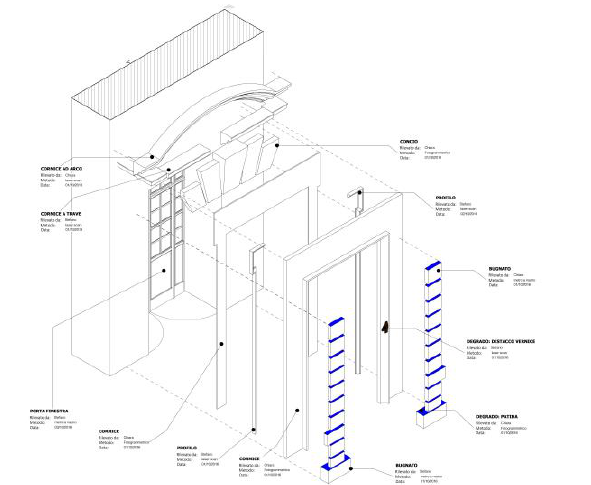
Figure 12. Exploded axonometry that shows the complex semantic decomposition of each single architectural subcomponent